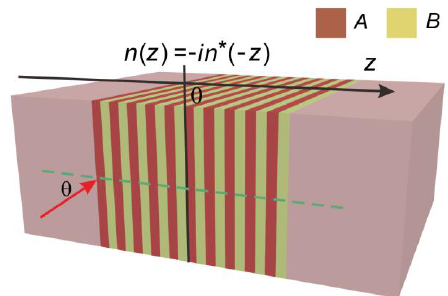
Figure 1. Schematic of the one-dimension complex anti-parity–time (PT) symmetric photonic crystals (PCs), where the complex refractive indices were distributed in n ( z ) = − in *( − z ). For the primitive unit-cell layers A and B, the thickness was L = 125 µ m and the complex refractive indices were n a = 0.3166 + 0.0158 i and n b = 0.0158 + 0.3166 i , respectively. The imaginary part was positive for gain material and negative for loss material.